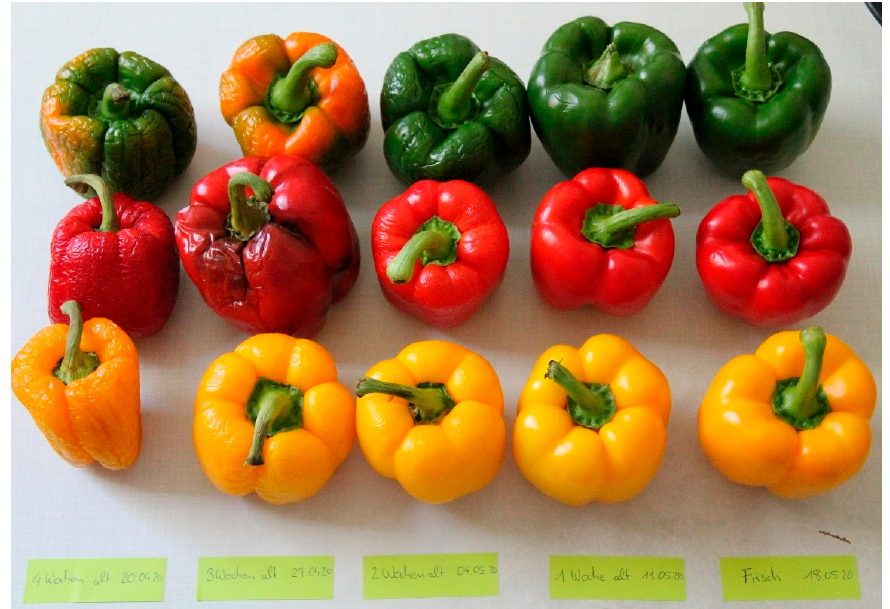
Figure 1. Bell pepper fruit employed for the present freshness index evaluation, in their fresh con- dition and the fresh specimen on the right and then stored for 14 days (left